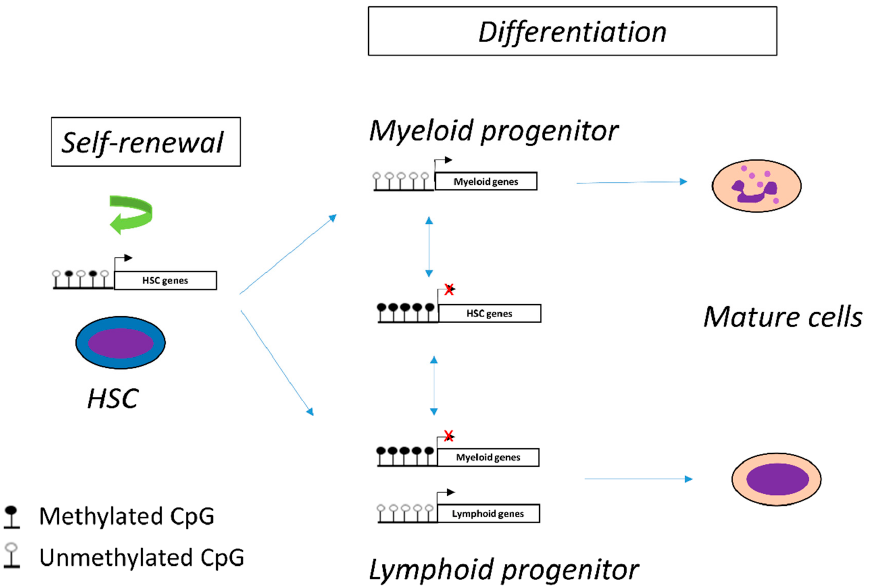
Figure 2. DNA methylation controls hematopoietic cell differentiation and self-renewal of hematopoietic stem cells (HSC). etic stem cells